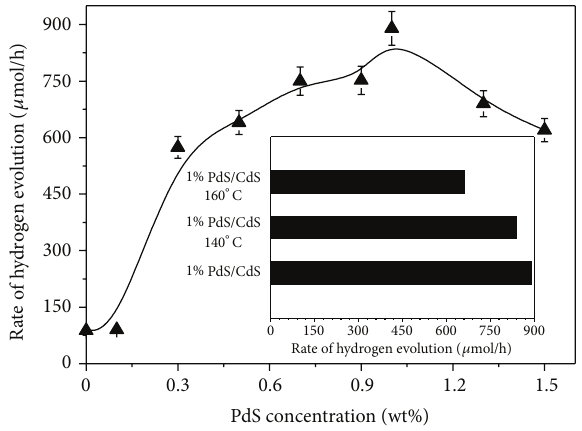
Figure 1: Rate of hydrogen evolution on PdS/CdS samples loaded with different amounts of PdS under visible light; (insert) rate of hydrogen evolution on PdS/CdS samples loaded with 1wt% amount of PdS prepared by different hydrothermal temperatures and in situ coprecipitation.